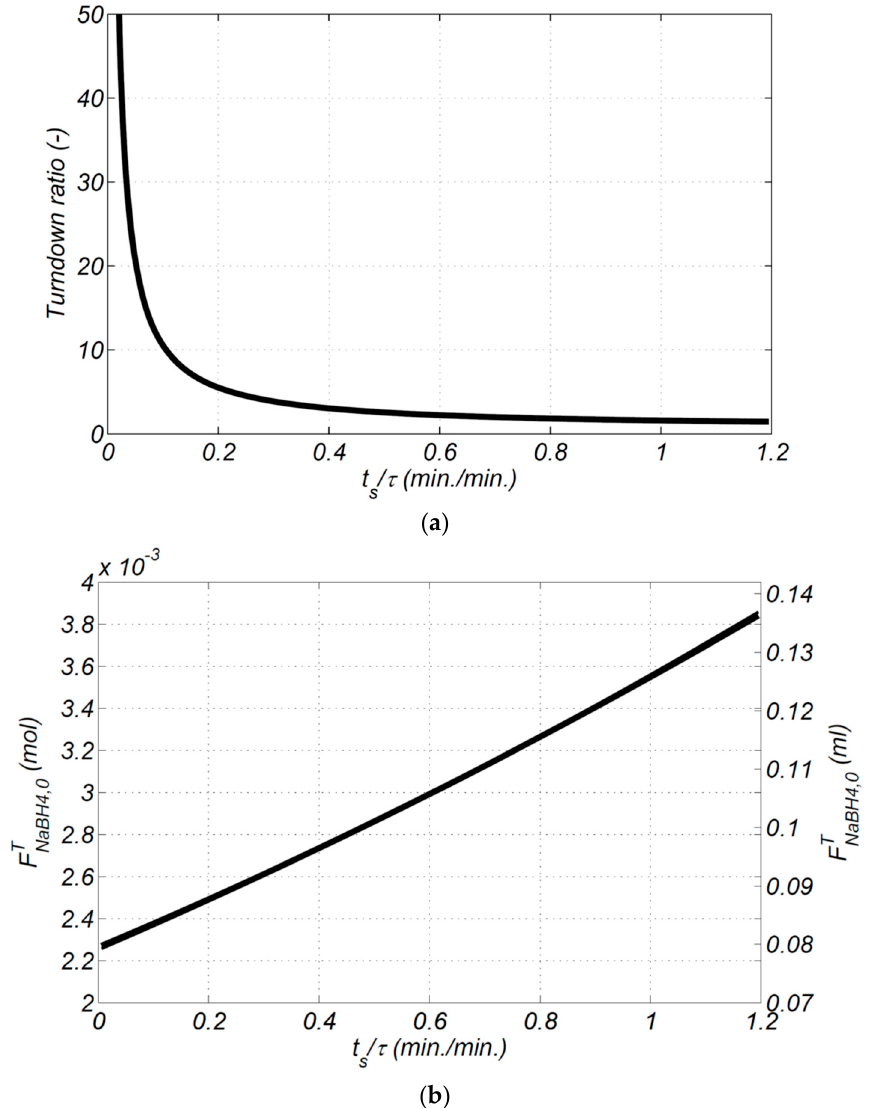
T F (mol or ml) at τ = 1.67 NaBH 0,4 (mol or ml) at τ = 1.67 min. NaBH 4,0